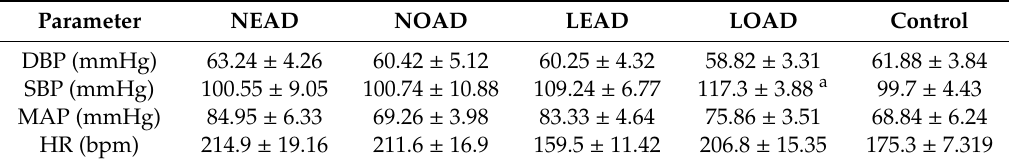
Table 3. Blood pressure and heart rate values in the various groups over 60 days of treatment. Parameter NEAD NOAD LEAD LOAD